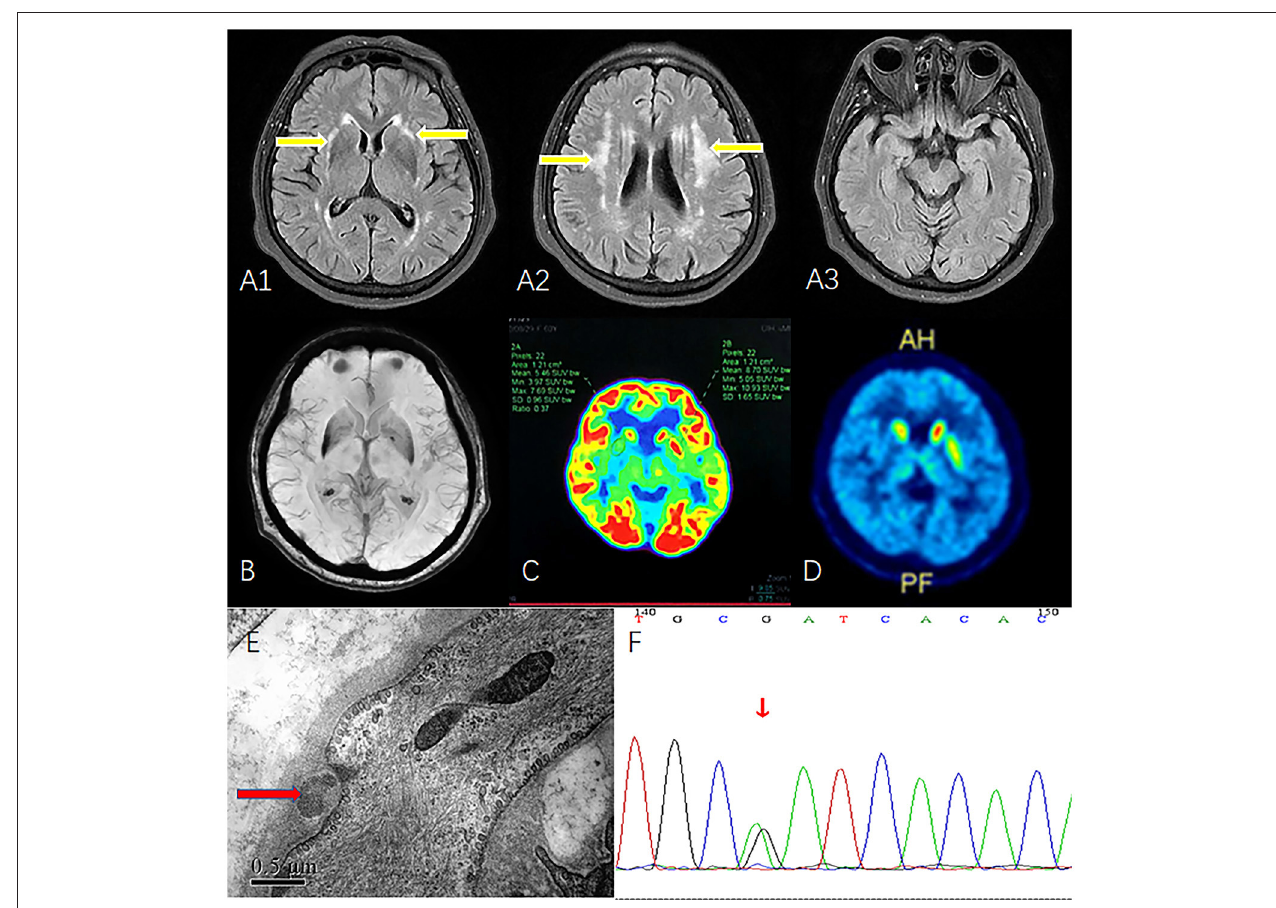
FIGURE 1 | MRI, FDG-PET, VMAT2-PET, skin biopsy, and Sanger sequencing. (A1) FLAIR image shows white matter hyperintensity of the external capsule (yellow arrow). (A2) FLAIR image shows periventricular white matter hyperintensity (yellow arrow). (A3) Bilateral temporal poles show normal signal. (B) Flair image revealed no clearly cerebellar atrophy. (C) FDG-PET reveals hypometabolism in the right putamen. (D) VMAT2 indicates low-intensity signals in right putamen. (E) Skin biopsy shows granular osmiophilic material near the basement membrane of arteriolar smooth muscle cells (red arrow). (F) Sanger sequencing confirmed the mutation c. 1630C > T (p.R544C). MRI, magnetic resonance imaging; FDG-PET, fluorodeoxyglucose-positron emission tomography; FLAIR, fluid-attenuated inversion recovery; VMAT2, vesicular monoamine transporter type